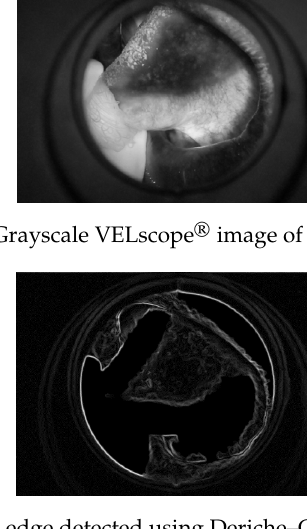
Figure 12. Region edge detected using Deriche–Canny edge detector.